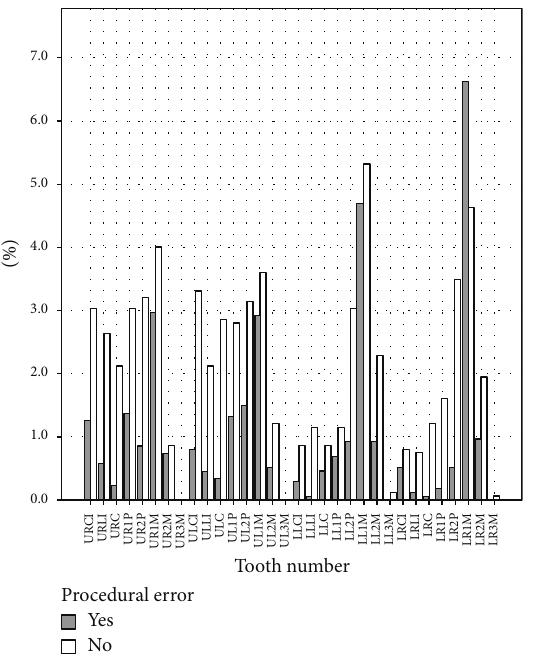
Figure 6: Overall distribution of errors in individual teeth.